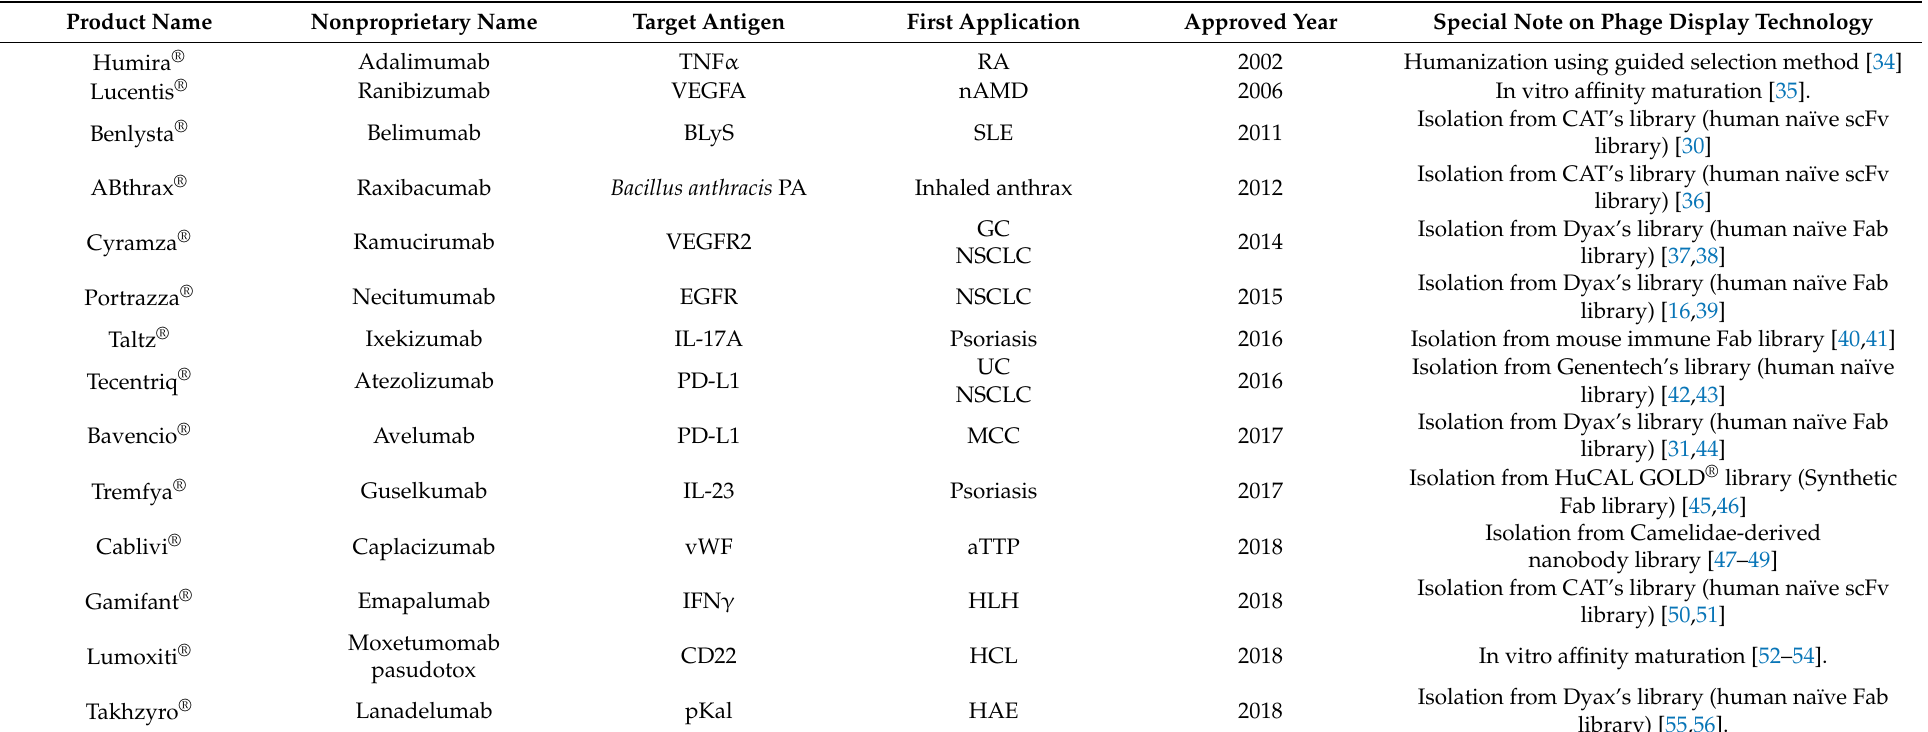
Table 1. A list of approved antibody drugs derived from phage display